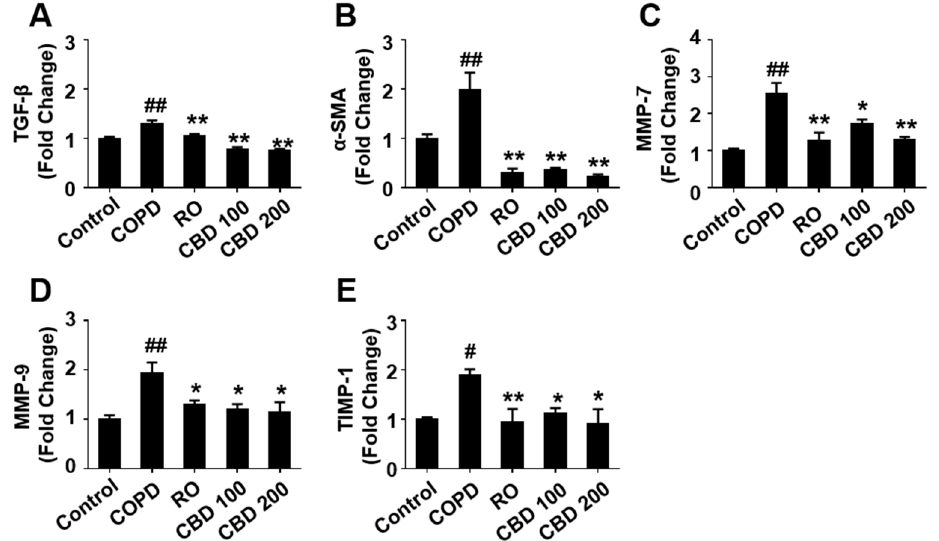
Figure 5. Effects of CBD on levels of mRNAs encoding pulmonary ‐ fibrosis ‐ related genes in lung tissues. Levels of ( A ) TGF- β , ( B ) α -SMA, ( C ) MMP-7, ( D ) MMP-9, and ( E ) TIMP-1 mRNAs were tissues. Levels of ( A ) TGF ‐β , ( B ) α‐ SMA, ( C ) MMP ‐ 7, ( D ) MMP ‐ 9, and ( E ) TIMP ‐ 1 mRNAs were measured by RT-PCR. Control: mice instilled intratracheally with normal saline; COPD: mice exposed measured by RT ‐ PCR. Control: mice instilled intratracheally with normal saline; COPD: mice ex ‐ to CS and LPS; RO: mice exposed to 10 mg/kg roflumilast plus CS and LPS; CBD 100: mice exposed to 100 mg/kg CBD plus CS and LPS; CBD 200: mice exposed to 200 mg/kg CBD plus CS and LPS. Results are presented as means ± SEMs. # p < 0.05, ## p < 0.01 compared with the control group; * p < 0.05, ** p < 0.01 compared with the COPD